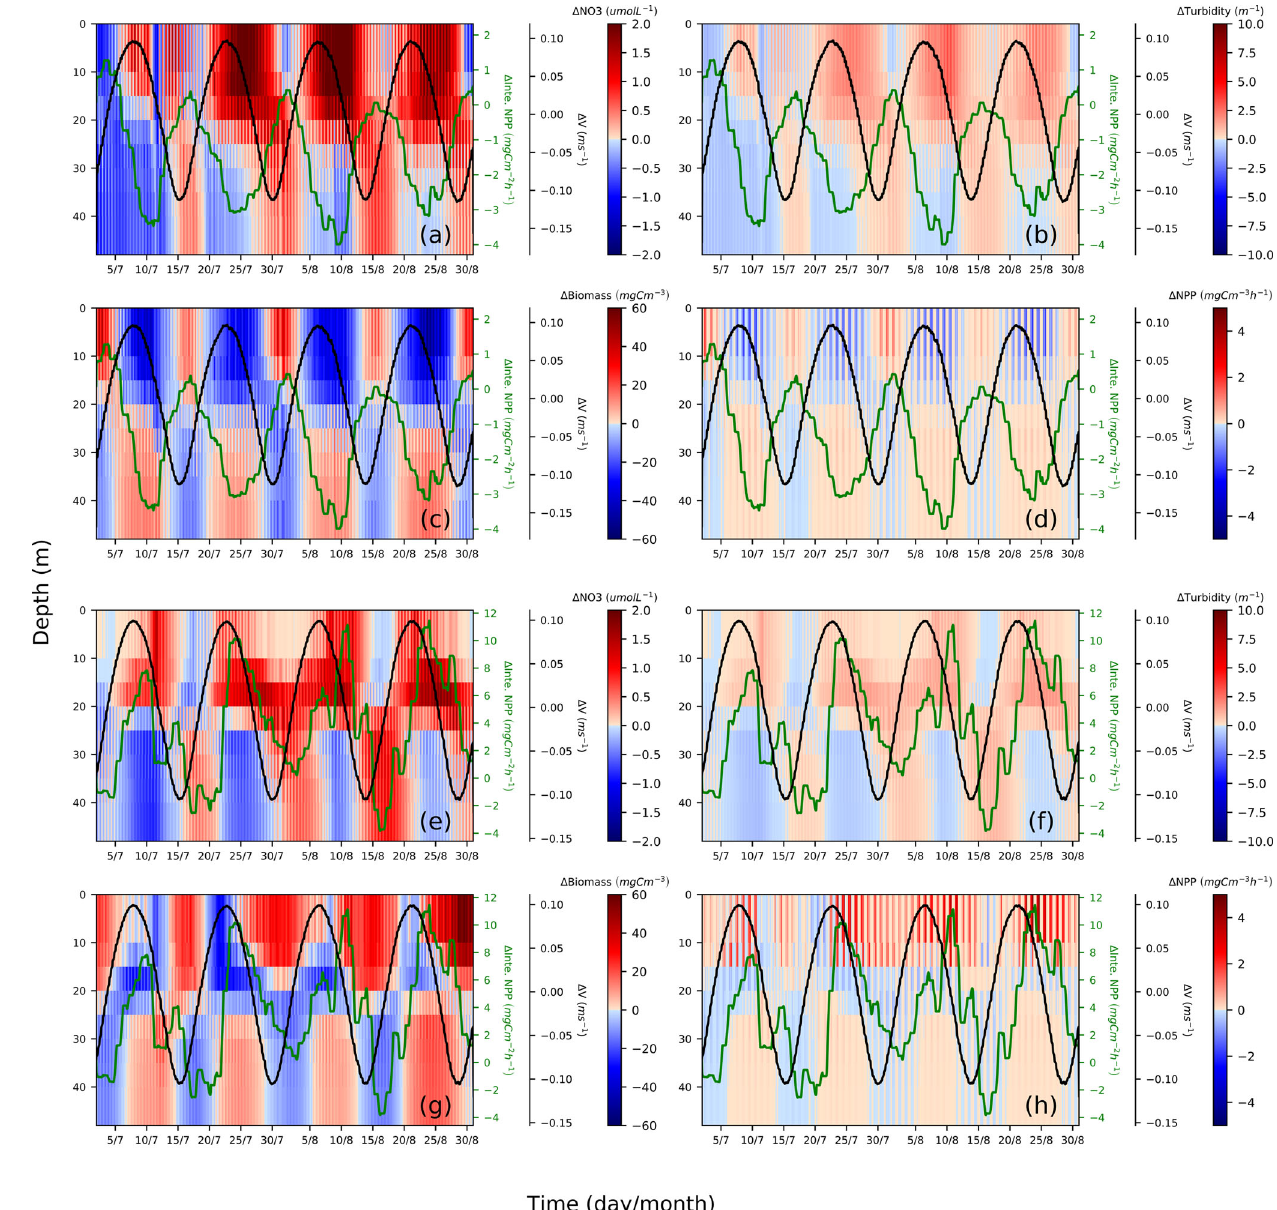
Figure 10. Spring–neap cycle impact on nitrate (a, e) , turbidity (b, f) , phytoplankton biomass (c, g) and primary production (d, h) . Differ- ences between the two scenarios (tidal scenario (M 2 + S 2 ) − M 2 tidal scenario) are presented for two characteristic points, i.e., EH: (a) – (d) , WDB: (e) – (h) . To show the periodical fluctuation of currents and NPP and relate these fluctuations to changes in nitrate, turbidity, biomass and NPP, the differences in the depth-averaged velocity amplitude (black) and depth-integrated NPP (green) are presented in each subplot; both time series underwent smoothing with a 24h running